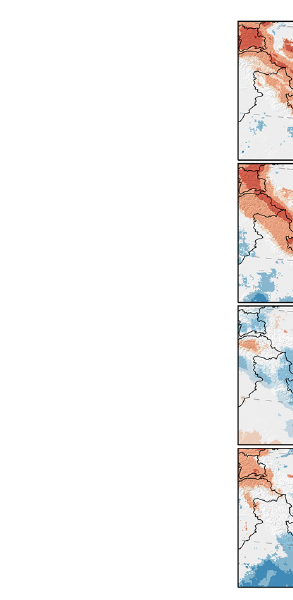
Figure 3. Coefficient of correlation (rho) between horizontal wind speed at 300hPa (WS300) and precipitation for all months (01–12). Positive correlations are denoted in red, while negative correlations are denoted in